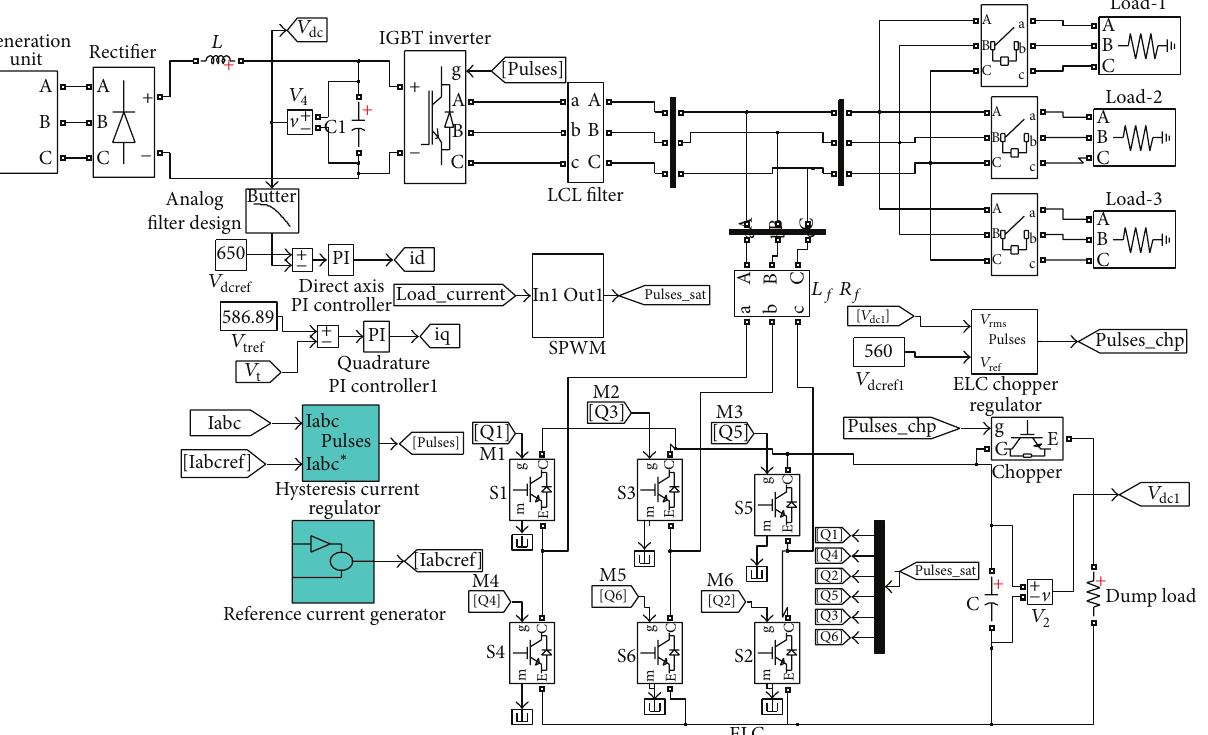
Figure 10: MATLAB model of AG-ELC